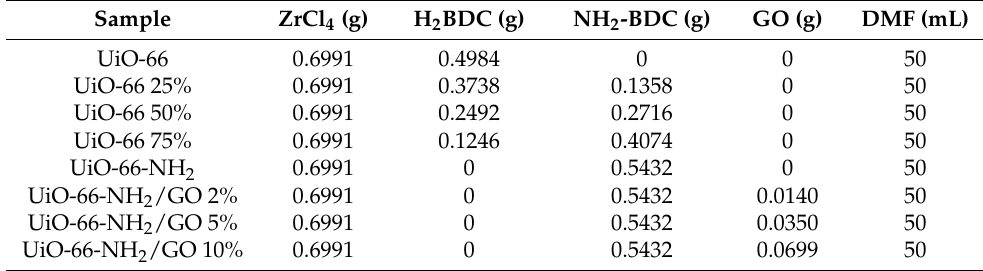
Table 1. Preparation parameters of